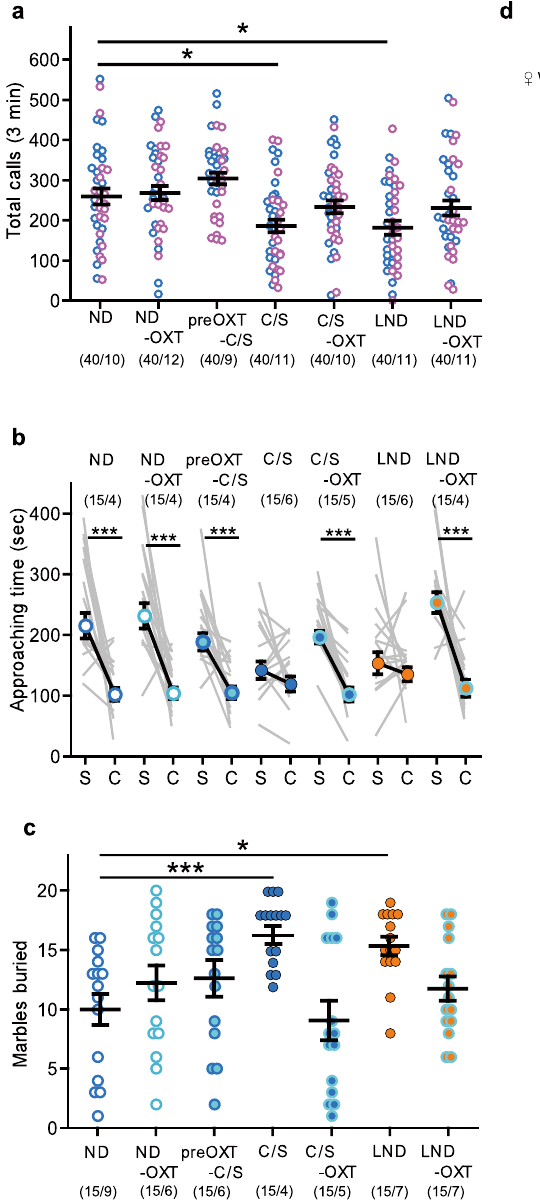
Figure 2. Effects of perinatal oxytocin (OXT) or prenatal OXT receptor antagonist treatment on offspring behaviors. ( a ) Number of USV calls at PD 8 (in all seven groups, n = 40: male = 20, female = 20; ND vs. C/S, p = 0.016; ND vs. born to L-368,899-treated dams via natural delivery [LND], p = 0.009). ( b ) Approaching time of male mice to the stranger cage (S) and the empty cage (C) in the 3-CSI test (ND: p = 0.001, ND-OXT: p < 0.001, preOXT-C/S: p < 0.001, p = 0.268, C/S-OXT: p < 0.001, LND: p = 0.804, LND-OXT: p < 0.001). ( c ) Number of marbles buried by male mice in the marble burying (MB) test (ND vs. C/S: p < 0.001, ND vs. LND: p = 0.035). Data represent the mean ± SEM. The numbers in parentheses indicate the numbers of mice tested and their litters (mice/litters) in each group. * p < 0.05, *** p < Fig. 1j,k). This finding is different from that reported in another ASD mouse model, which was deficient in Cntnap2 17 . Behavioral effects in wild‑type offspring born to OXT‑knockout dams. Next, we re-examined our hypothesis using OXT-knockout (KO) mice. In vitro fertilized (IVF) wild-type (WT) C57BL/6J mouse embryos were implanted into pseudopregnant OXT-KO or WT female C57BL/6J mice. Because OXT-KO female mice show no deficits in gestation or parturition 18 , we were able to examine mice who did not receive OXT from their dams during delivery (Fig. 3i). Unexpectedly, the USV results of mice born to OXT-KO dams (IVF-OKO) were different from those of C/S mice. We did not detect any decrease in the total USV calls of IVF-OKO compared with mice born to WT dams (IVF-WT). Moreover, USV call numbers appeared to be different between the